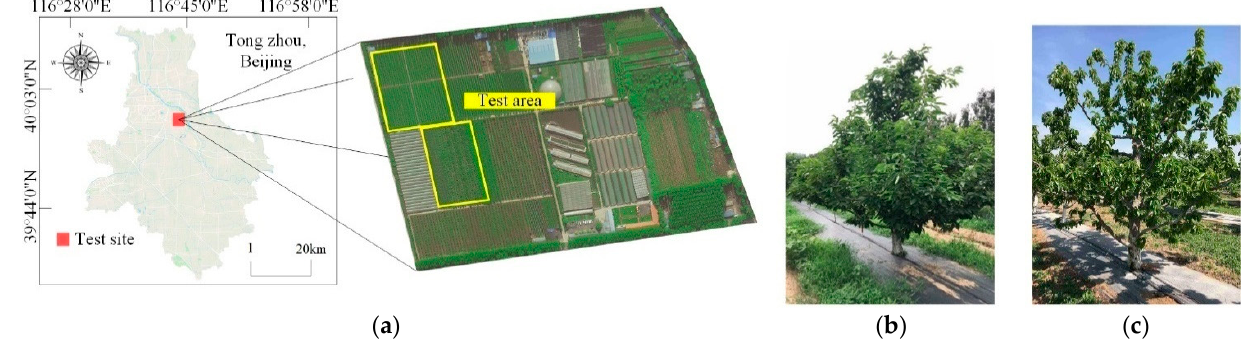
Figure 2. Test site, and the illustrations of images under different lighting conditions and weeds densities: ( a ) cherry orchard in Tongzhou Beijing, ( b ) cloudy day with high-density weeds and ( c ) sunny day with normal-density